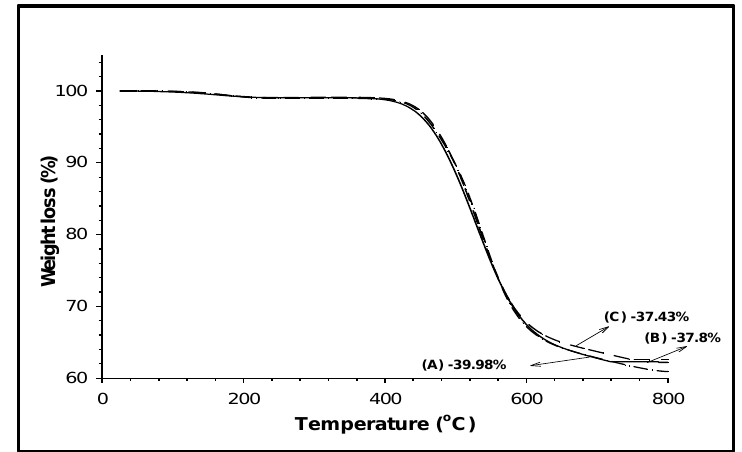
Figure 14. TGA thermograms; Ar pure ( A ), Ar-CNT-C ( B ) and Ar-CNT-P( C ) composites with 5 wt % CNT.